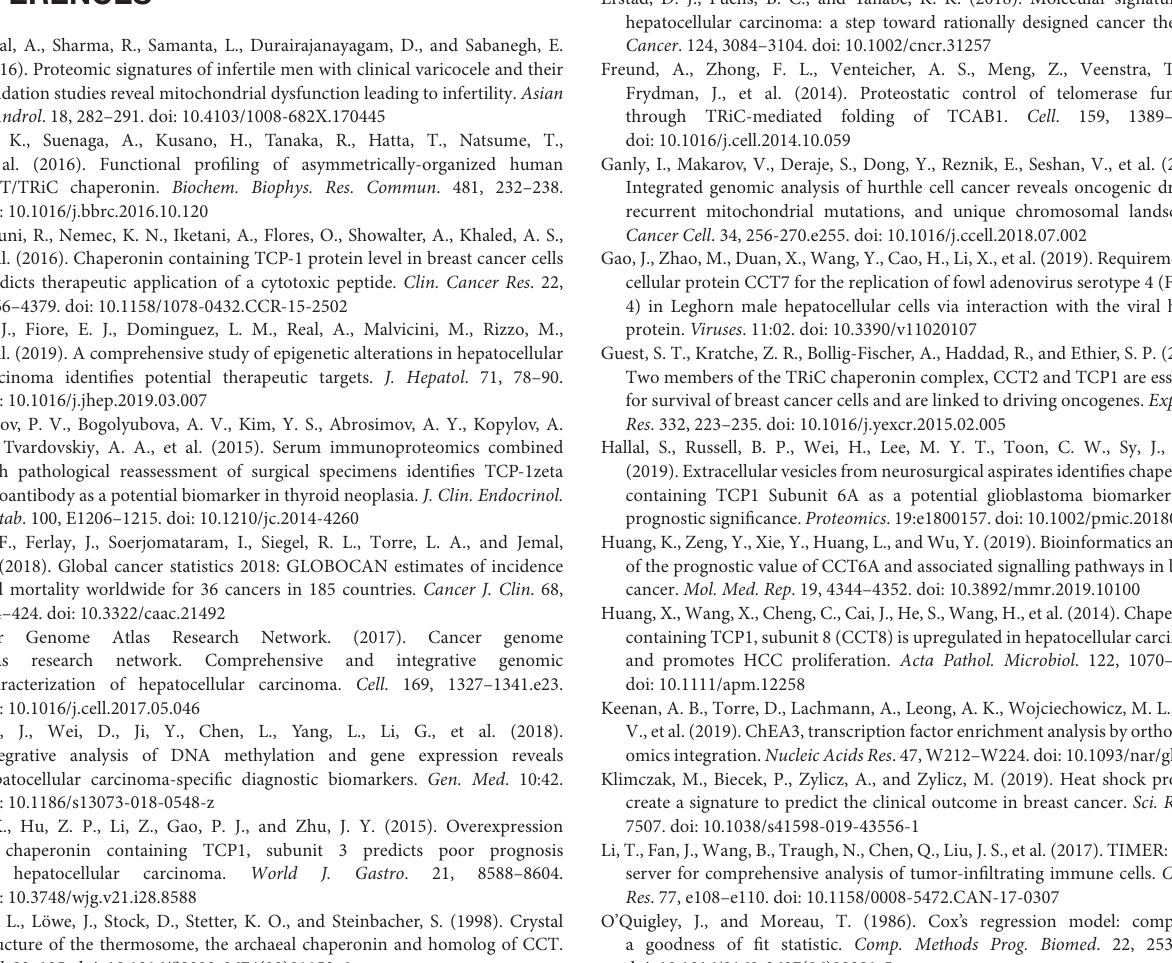
Supplementary Figure 2 | Multivariate analysis of CCT subunit genes and clinical characteristics in the ICGC cohort. Supplementary Figure 3 | Construction of 3-genes signature. (A) The coefficients obtained from the LASSO algorithm. (B) Stepwise multivariate Cox regression was applied to built final model. Supplementary Figure 4 | Validation of 3-gene signature in GSE14520 cohort. (A) The distribution of risk scores, survival time and gene expression levels in GSE14520 cohort. (B) overall survival difference between high-risk and low-risk group. Supplementary Figure 5 | Relationship between risk score, clinical characteristics and expression of CCT6B, CCT4, and CCT6A. The heatmap shows clinical characteristics and the expression levels of CCT6B, CCT4, and CCT6A in the low- and high- group of HCC patients in training (A) , validation (B) and testing (C) set. ∗ P < 0.05, ∗∗ P < 0.01 and ∗∗∗ P < 0.001. Supplementary Table 1 | Univariate analysis of CCT subunit genes and clinical characteristics in the TCGA cohort. Supplementary Table 2 | Univariate analysis of CCT subunit genes and clinical characteristics in the ICGC